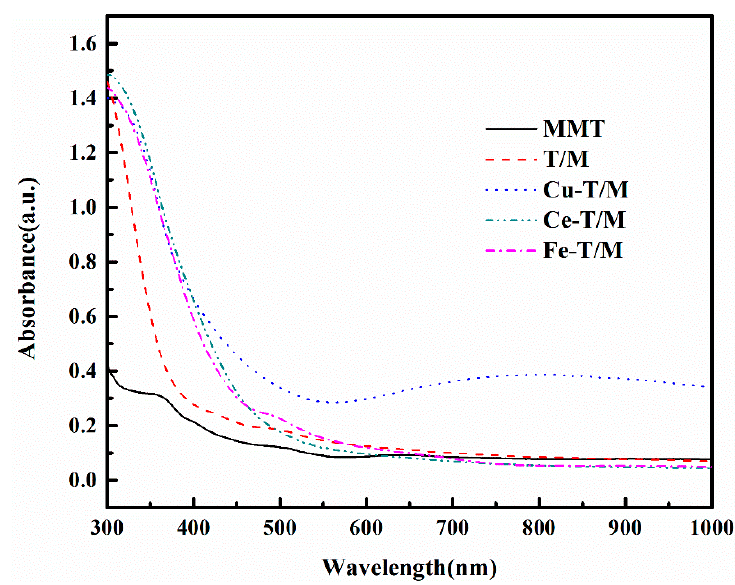
Figure 2. UV-Vis spectrum of metal doped TiO 2 pillared montmorillonite.